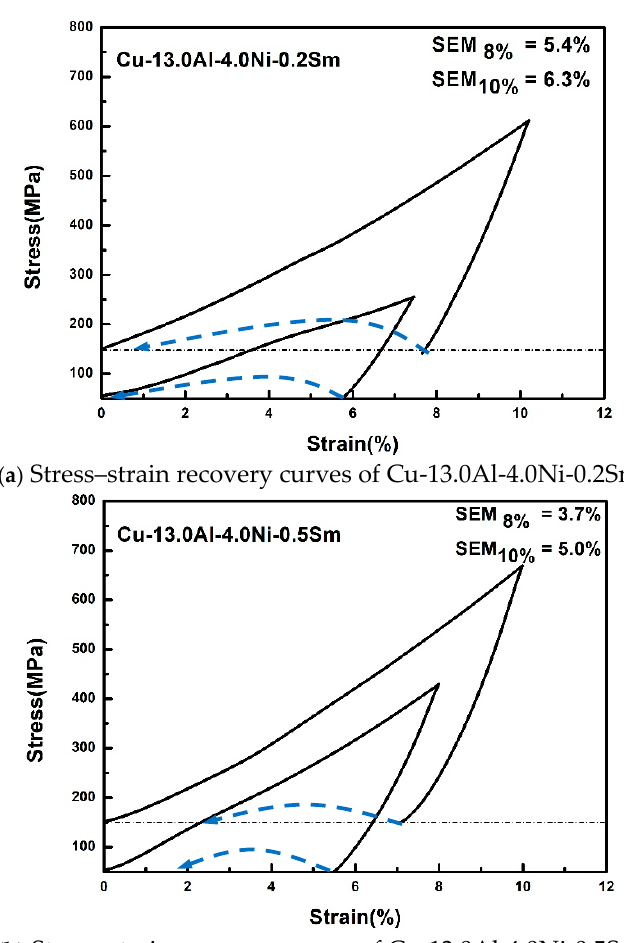
Figure 6. Stress–strain recovery curves of Cu-13.0Al-4.0Ni- x Sm ( x = 0.2, 0.5) alloys under pre-strains of 8% and 10%. The arrow line represents the recovery strain (SME) after heating to 350 °C for 1 min.